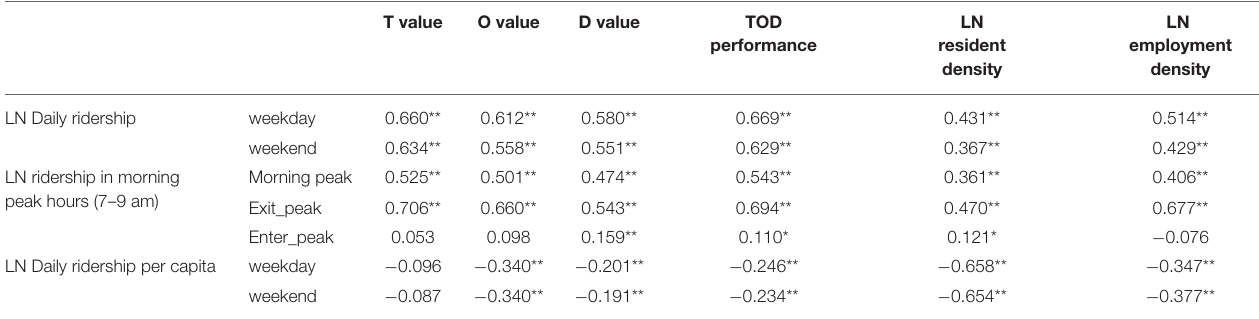
TABLE 3 | R correlation between ridership, ridership per capita, and TOD performance.